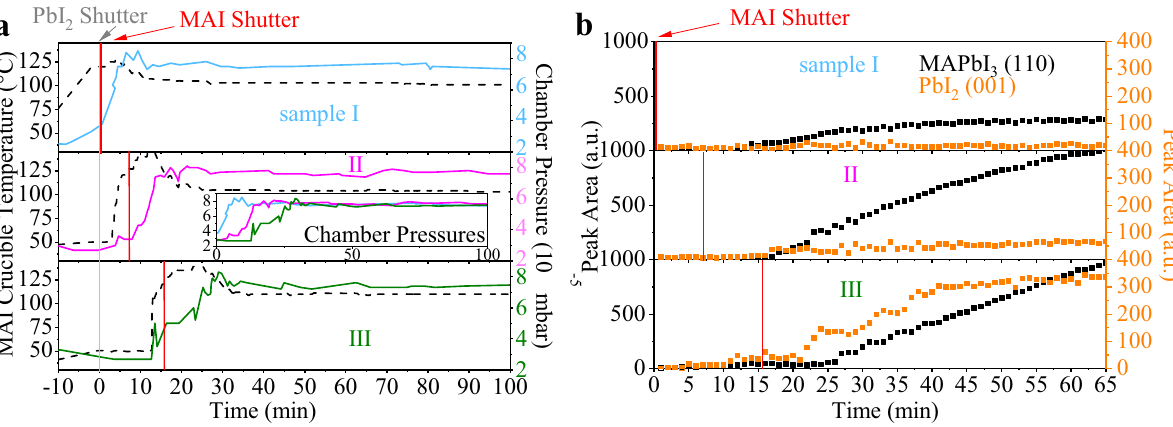
Figure 5. Characterizing initial growth during starting time variation: ( a ) course of the MAI crucible temperature (solid lines) and corresponding development of chamber pressure (dashed lines) during the first 100 min for samples I, II and III corresponding to different MAI evaporation onset times of t = 0/8/16 min. The grey and red lines indicate the evaporation onset times for PbI 2 and MAI shutters. The inset shows a direct comparison of chamber pressures. ( b ) Evolution of (110) MAPbI 3 (black) and (001) PbI 2 (orange) peaks for samples I, II and